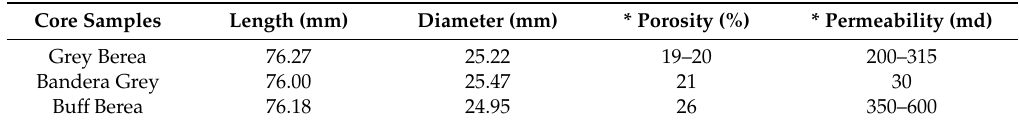
Table 1. Dimensions and petrophysical properties of core samples.